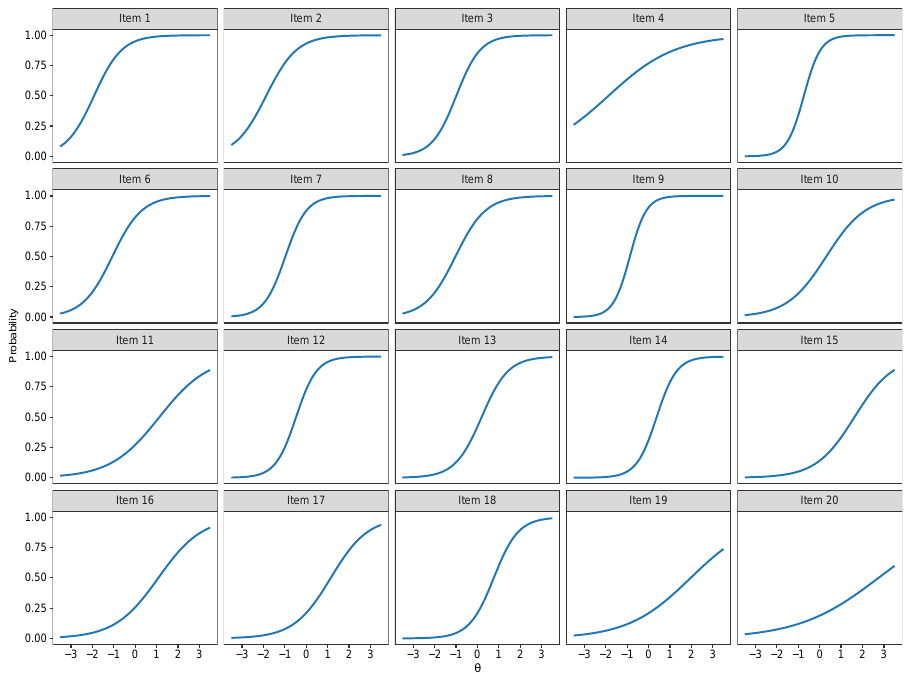
Figure 2. Item characteristic curve plots of the 2-Parameter Logistic Model.